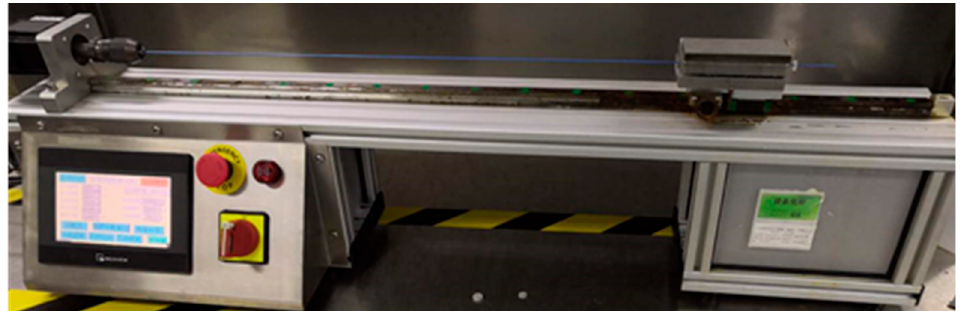
Figure 3. Torsion control test equipment.